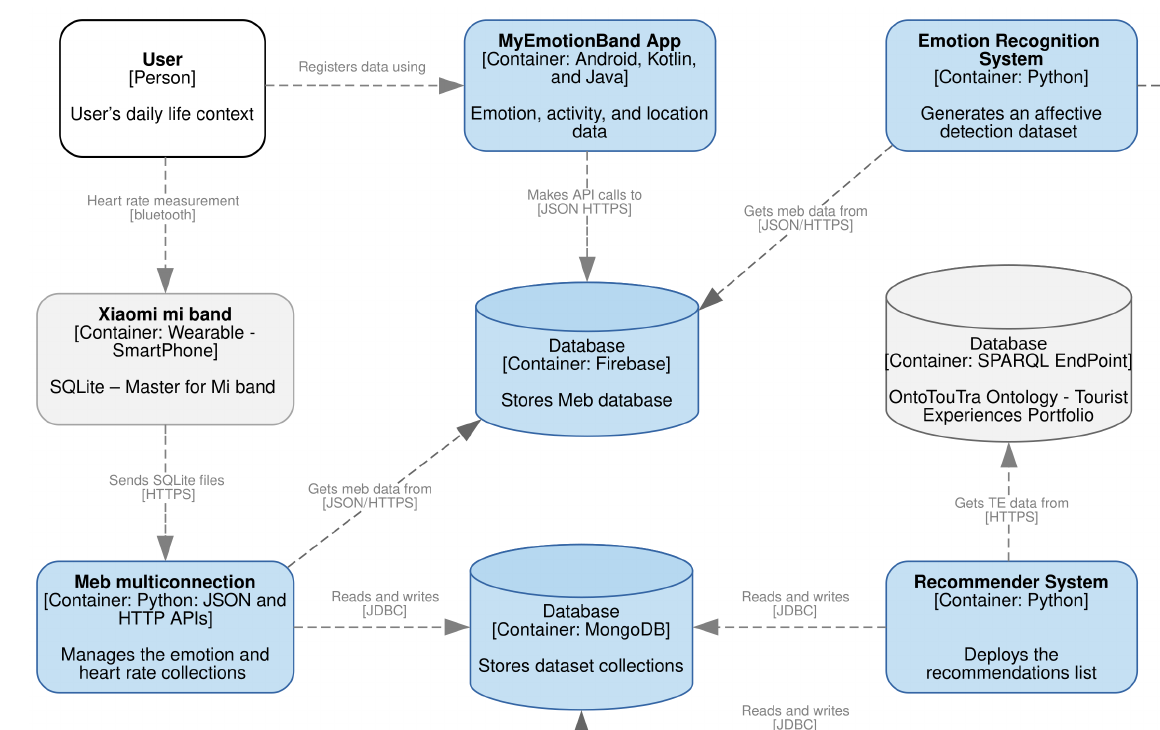
Figure 5. Containers of technological